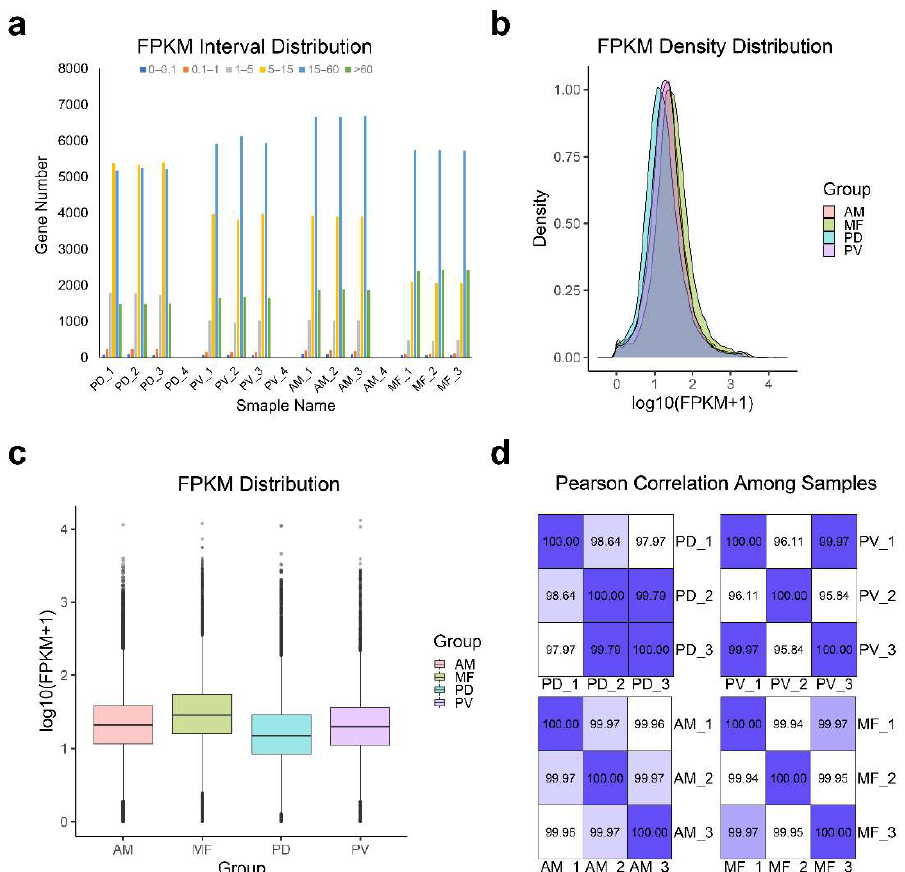
Figure 3. Summary of the coral gene expression level analysis. ( a ) FPKM interval distribution. The horizontal axis shows the sample name, different colors represent FPKM intervals, and the vertical axis represents the number of genes in each interval. ( b ) FPKM density distribution. The horizontal axis represents the log10 (FPKM + 1) values, and the vertical axis represents the density of genes with different expression levels. ( c ) FPKM box plot. The horizontal axis shows the sample name, and the vertical axis represents the log10 (FPKM + 1) values. Each box plot shows five statistical values, including the maximum, upper quartile, median, lower quartile, and minimum, from top to bottom. ( d ) Pearson’s correlation among samples. The closer the value is to 1, the better the correlation. Pd: P. damicornis ; Pv: P. verrucosa ; Am: A. muricata ; and Mf: M. foliosa .